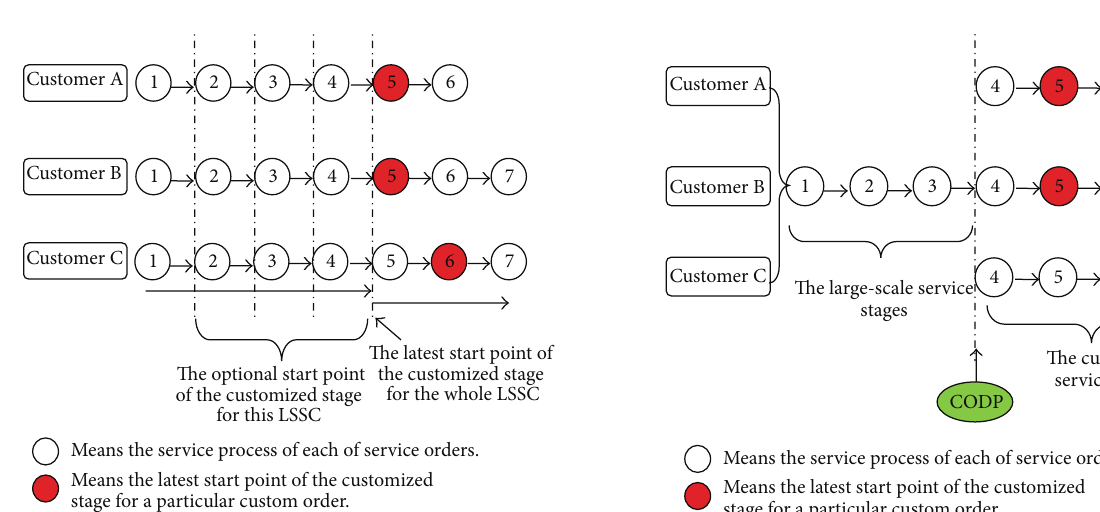
Figure 2: Take CODP is 𝑘 = 4 for example, the orders’ operation processes schematic